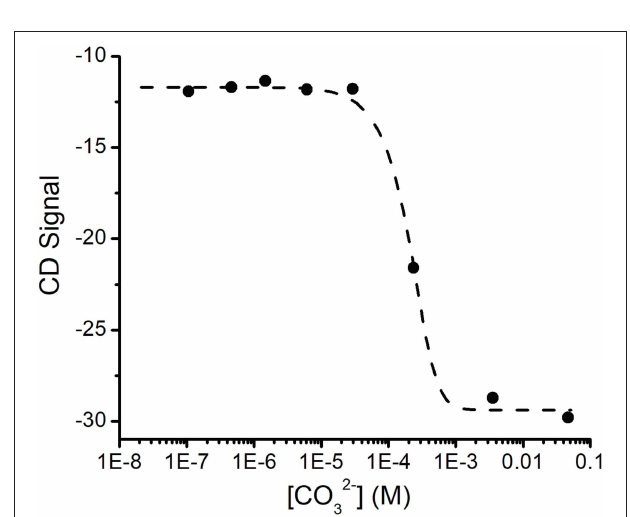
FIGURE 3 | Determination of the K d for UO 2 + 2 binding SUP by competition with CO 2 − 3 . Increasing concentrations of CO 2 − 3 ion compete for UO 2 + 2 and the displacement of UO 2 + 2 was followed by changes in the CD spectrum of SUP. Experimental points were fitted using Dynafit (see Materials and Methods for